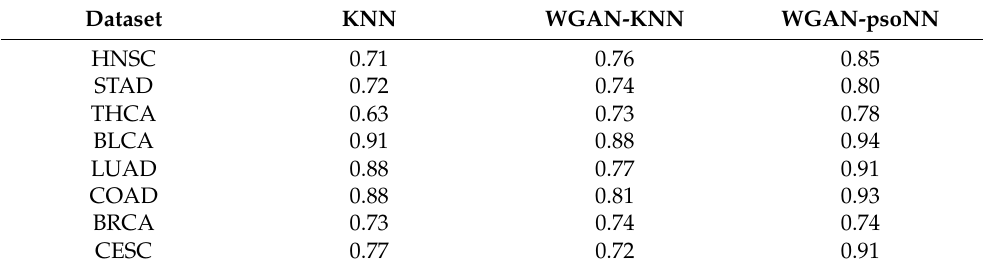
Table 4. Comparingthe prediction accuracy of KNN, WGAN-KNN and WGAN-psoNN.